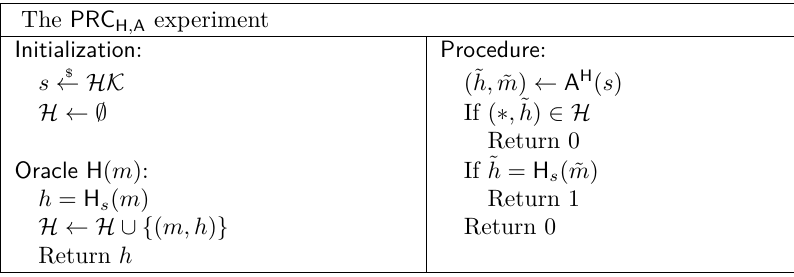
Table 6: The preimage resistance of H in the hash